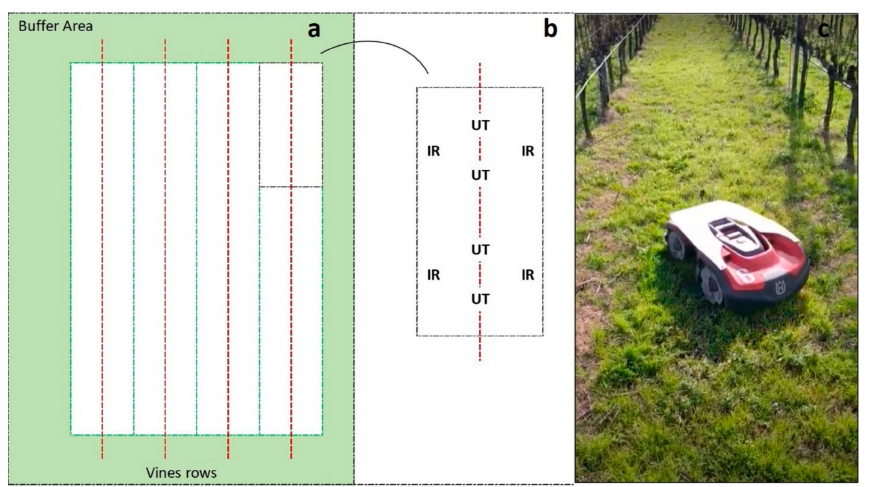
Figure 1. ( a ) Sketch map of the autonomously mowed (AM) area; ( b ) Detail of a single plot and measurements positions: IR (interrows) and UT (under-trellis); ( c ) Image of the autonomous mower operating during October